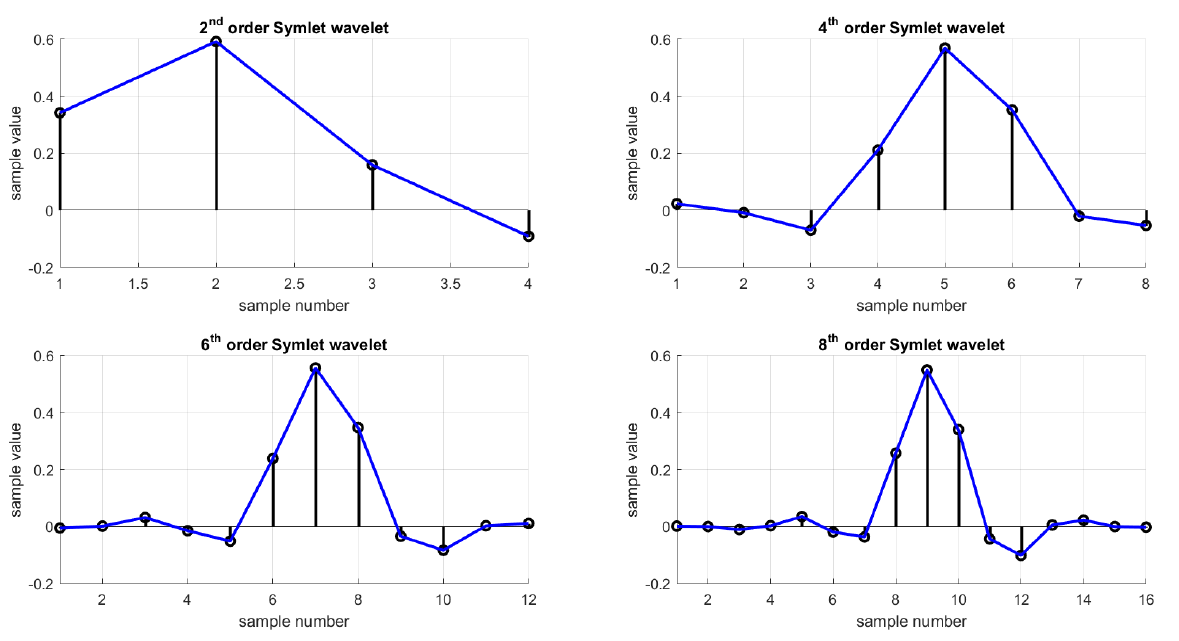
Figure A1. Symlet wavelet function in different orders.